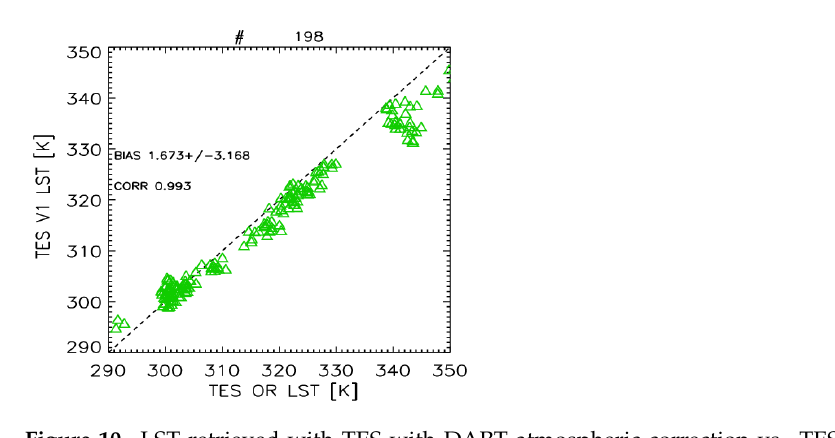
Figure 10. LST retrieved with TES with DART atmospheric correction vs. TES on TASI2DART dataset.